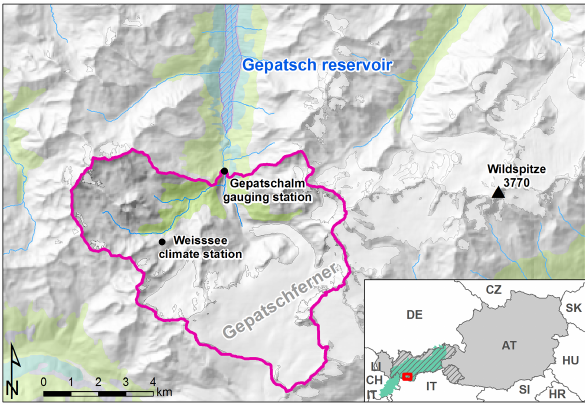
Figure 1. Map showing the study area located in Tyrol/Austria (hatched area in the small map) including the Gepatschalm catch- ment upstream of the Gepatsch reservoir. The Gepatschferner is the largest glacier in Western Austria (glaciers in light grey). The Inn river catchment is highlighted in green in the small